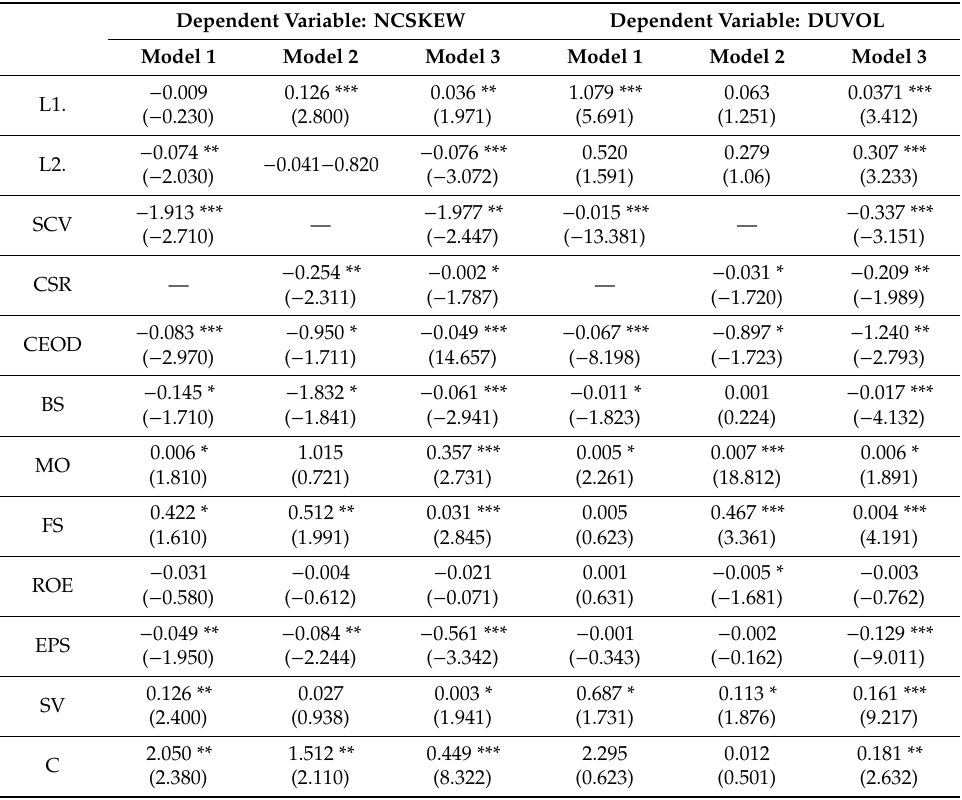
Table 4. The two-step system dynamic panel regression